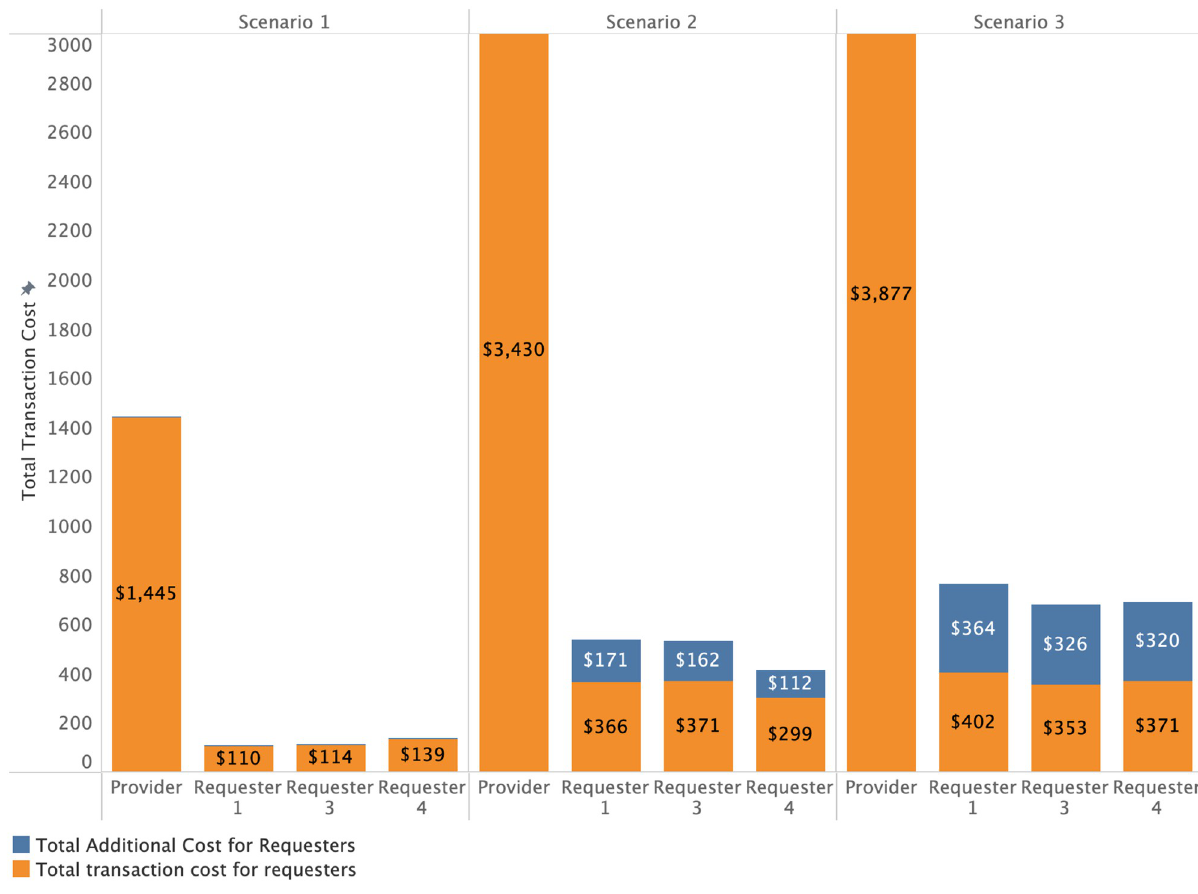
Fig 6. Total cost sum of the data provider vs top three data requesters per scenario.